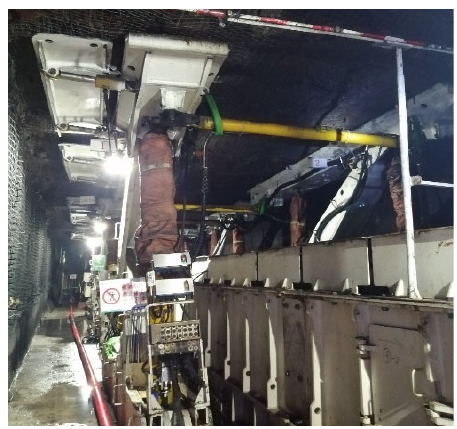
Figure 16. Self ‐ moving hydraulic support. Figure 16. Self-moving hydraulic